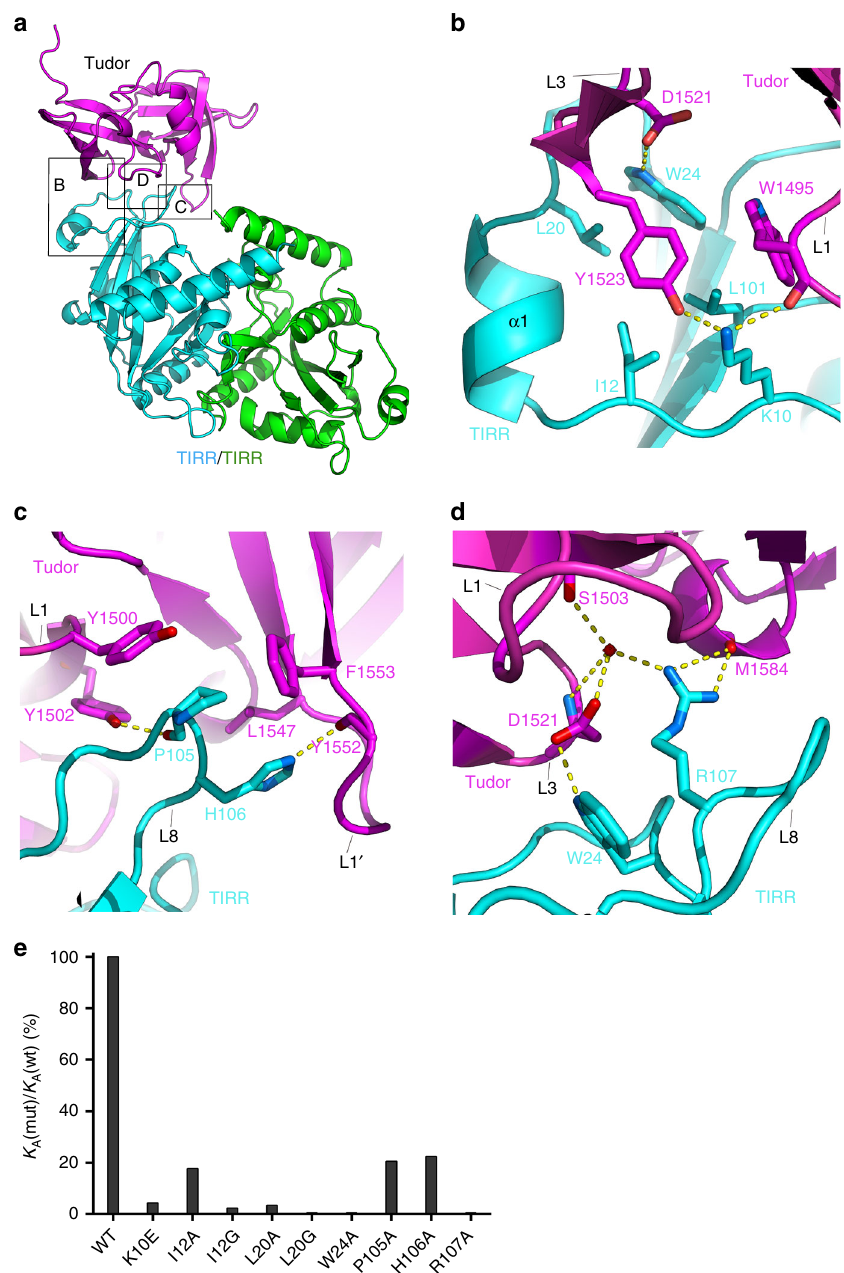
Fig. 2 Structure of TIRR in the complex of the 53BP1 tandem Tudor domain. a The overall view of TIRR/53BP1 Tudor complex. Highlighted are zoom-in regions for close-up view. b – d Close view of intermolecular contacts between 53BP1 Tudor and TIRR. Highlighted are 53BP1 Tudor residues interacting with TIRR through the N-terminal region ( b ), the L8-loop ( c ), and both regions ( d ). 53BP1 Tudor and TIRR are colored in magenta and cyan, respectively. e Effect of TIRR single-residue mutation on the binding of 53BP1 Tudor assayed by